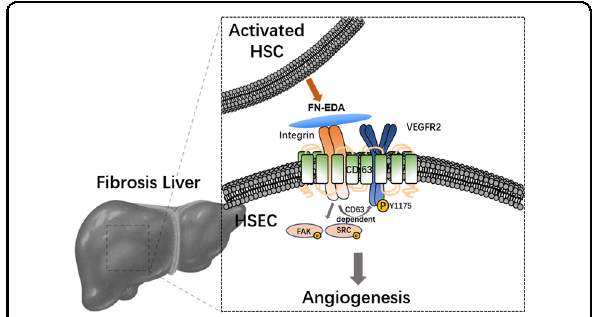
Fig. 7 Schematic fi gure illustrating the mechanism of FN-EDA promoting angiogenesis in hepatic fi brosis. In hepatic fi brosis, FN- EDA is over secreted by activated HSCs to HSECs and stimulates activation of HSECs via integrin-CD63-VEGFR2 receptor complex which leading to pathological